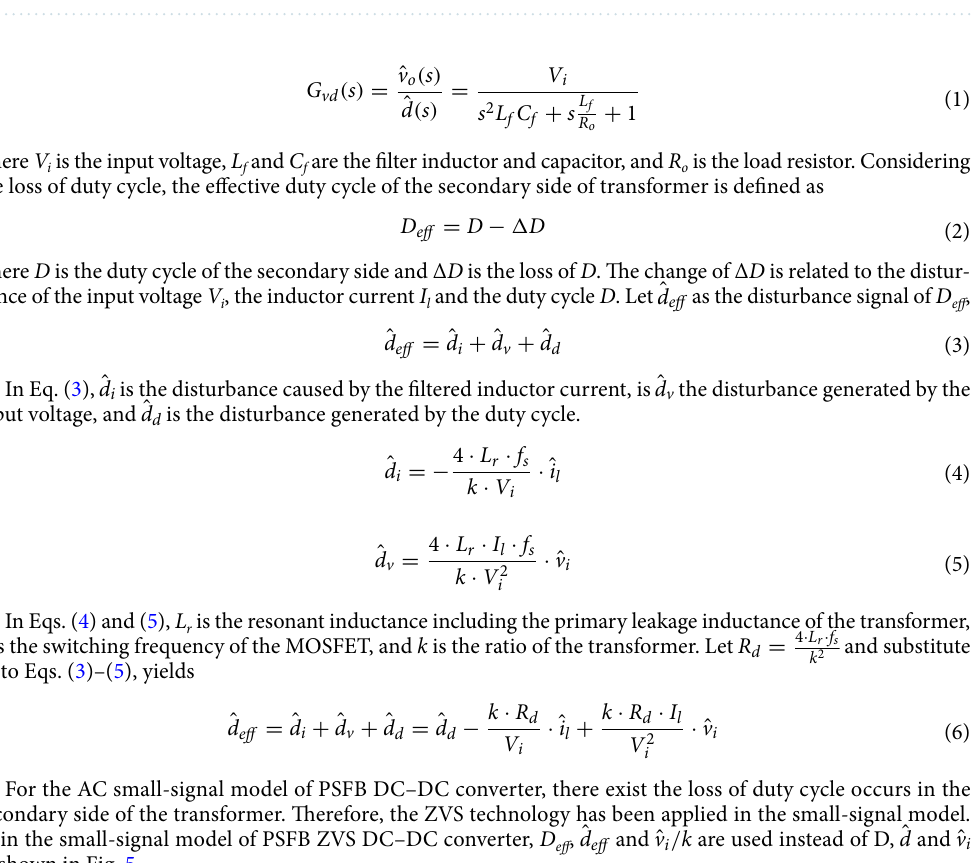
Figure 5. AC small-signal model of PSFB ZVS DC–DC